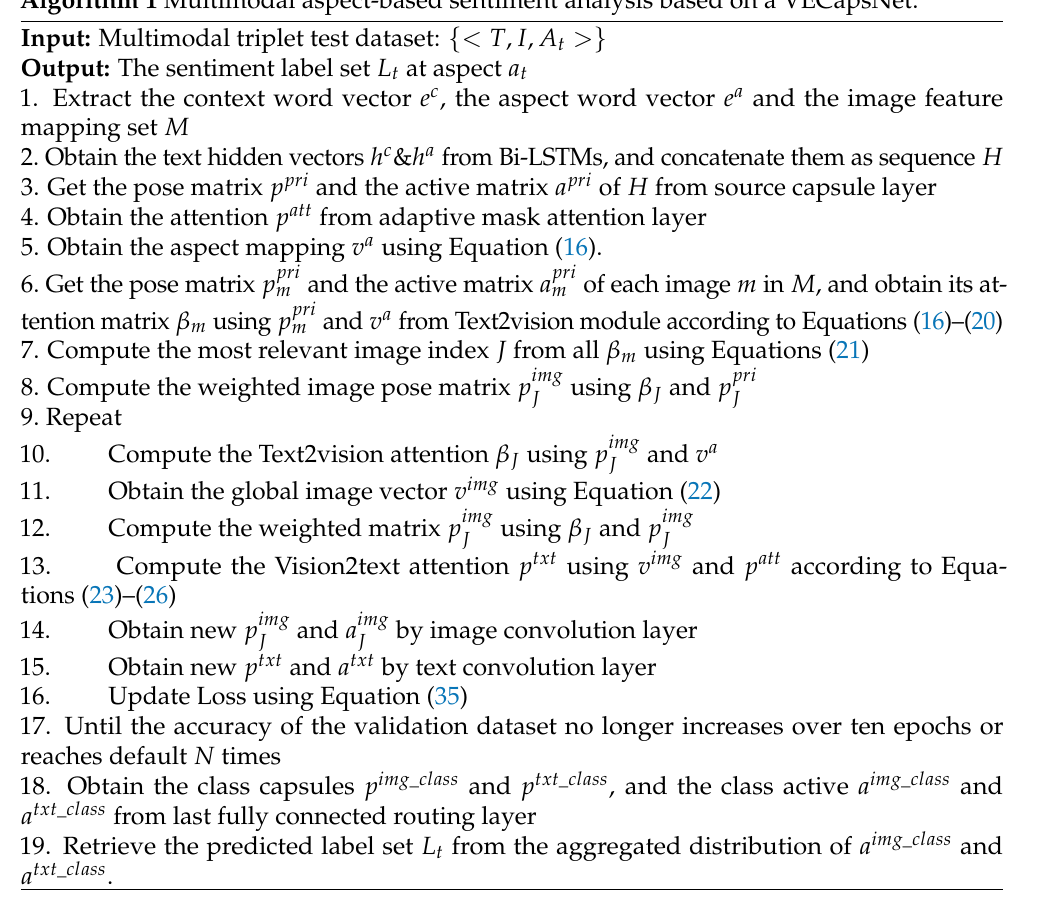
Algorithm 1 is the operational flow of VECapsNet. Algorithm 1 Multimodal aspect-based sentiment analysis based on a